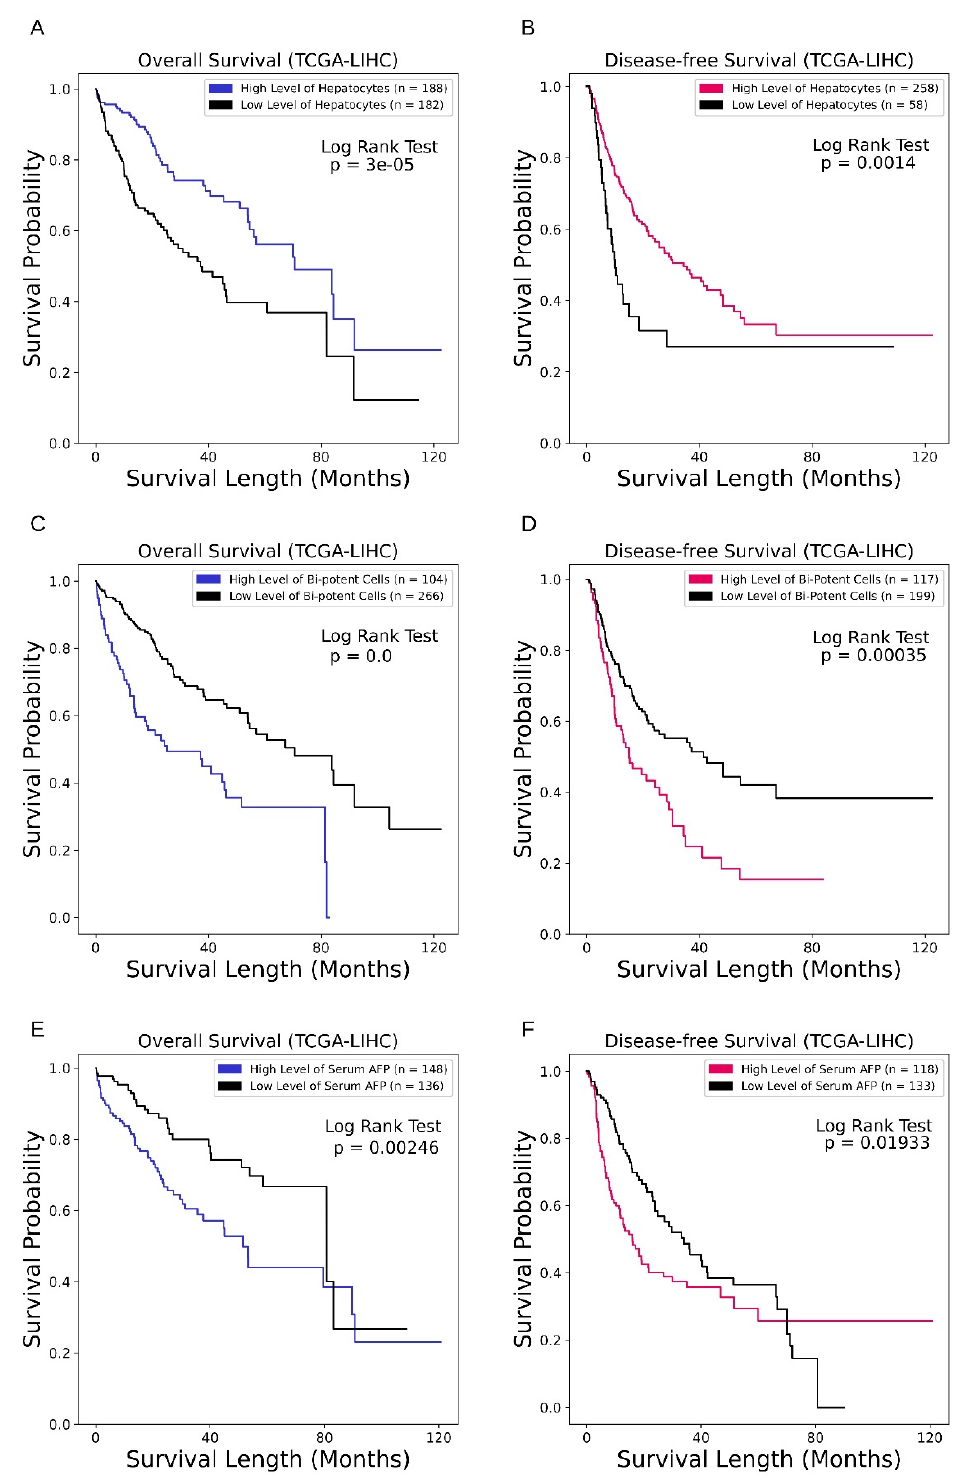
Figure 7. Impact of cell fractions on patients’ survivals. ( A , B ) Impact of hepatocyte fraction. High- level hepatocytes show both longer OS and DFS lengths. ( D – E ) Impact of bi-potent cell fraction. High-level bi-potent cells show lower OS and DFS lengths. ( C , F ) Impact of serum AFP at patient admission.